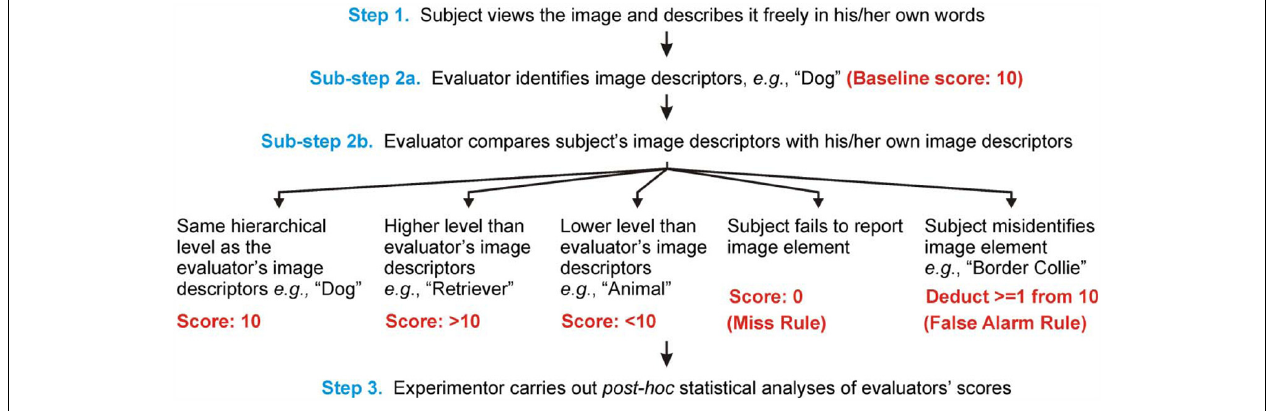
FIGURE 1 |Workflow of SDR. The three main steps of SDR, which involve obtaining, scoring and analyzing the subject’s reports respectively, are shown. Note that the subject, the evaluator, and the experimenter plays the most prominent role in Steps 1, 2, and 3, respectively.The two sub-steps of Step 2